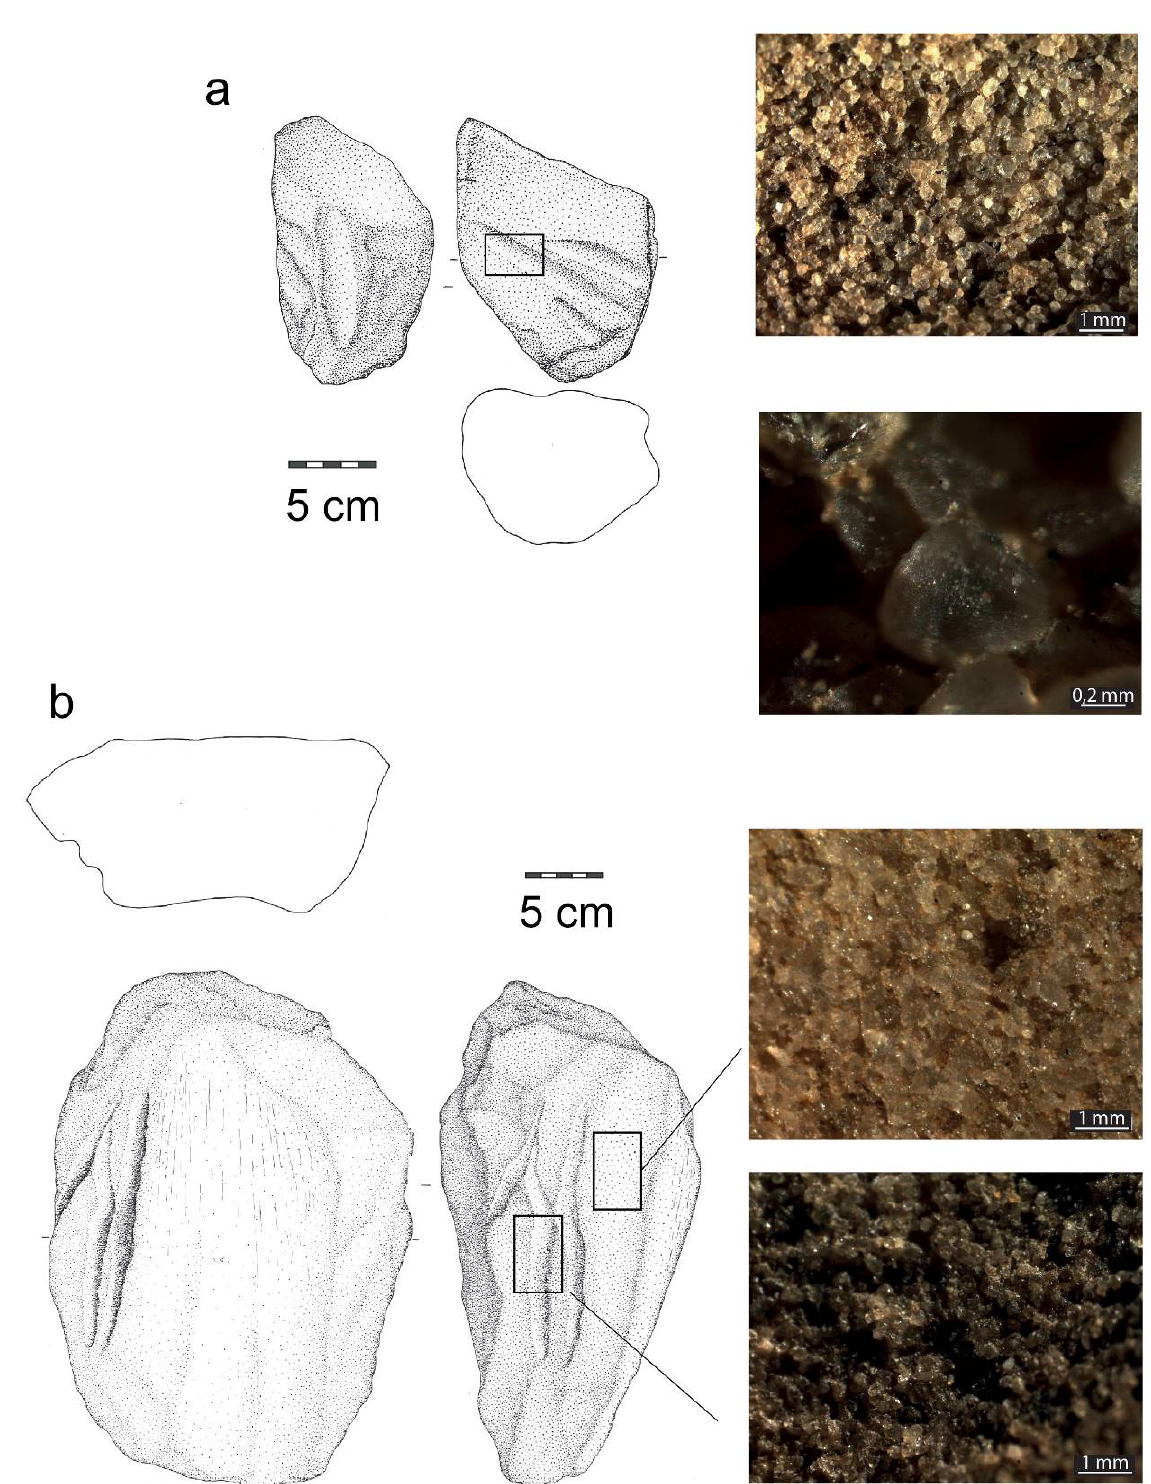
Figure 8. Flat and grooved massive abraders from the site of Ocquerre “la Rocluche”: a. use-wear comparable to bone tool abrasion (well-individualized grains, microfractured to altered surface, moderate levelling); b. use- wear comparable to hard mineral surface abrasion (high degree of levelling and microfracturing) (microphotos from Hamon